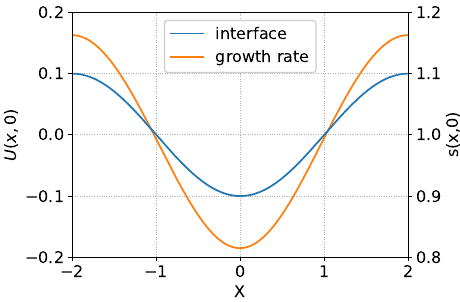
Figure 2. The interface (blue line) and growth rate (orange line) of the perturbations. Perturbation wave length is λ = 4, its amplitude is A =